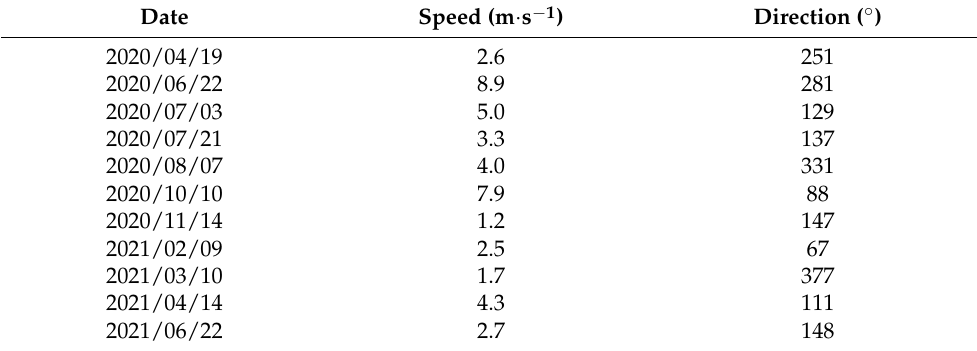
Figure 2. The middle (black) panel displays a colored composition of PRISMA hyperspectral image (2020/06/22) of the Korpezhe site. In this colour composition (R, G, B: 641, 546, 471 nm), the small darker areas are liquid surfaces, the brown area is sand, and the lighter areas are rocks. Image size is 1000 × 1000 pixels at a spatial resolution of 30 m. Boxes ( B – D ) (respectively green, orange and red) contain an emission point detected on a few images. Box A contains the most observed emission point in this dataset. Images of boxes from ( A ) to ( D ) come from Google Maps and Bing Maps. Table 2. Wind speed U 10 in m · s − 1 and wind direction expressed in meteorological data frame in degrees, for the images over the Korpezhe site. All images were acquired between 7:14 and 7:24 UTC, and a weighted average was calculated using the two closest ECMWF interpolated